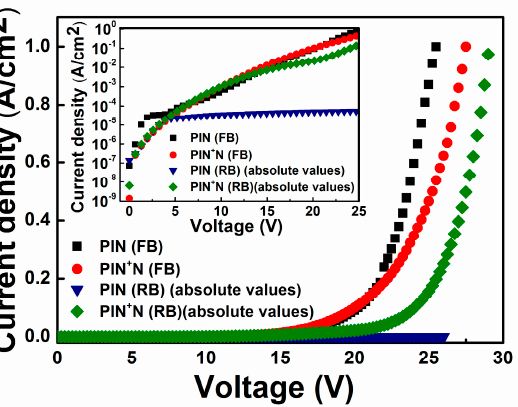
Figure 3. J vs. V characteristics in forward bias (FB) and reverse bias (RB) of the PIN and PIN + N devices. The inner graph shows Ln (J) vs. V in forward and reverses bias (absolute voltage values).